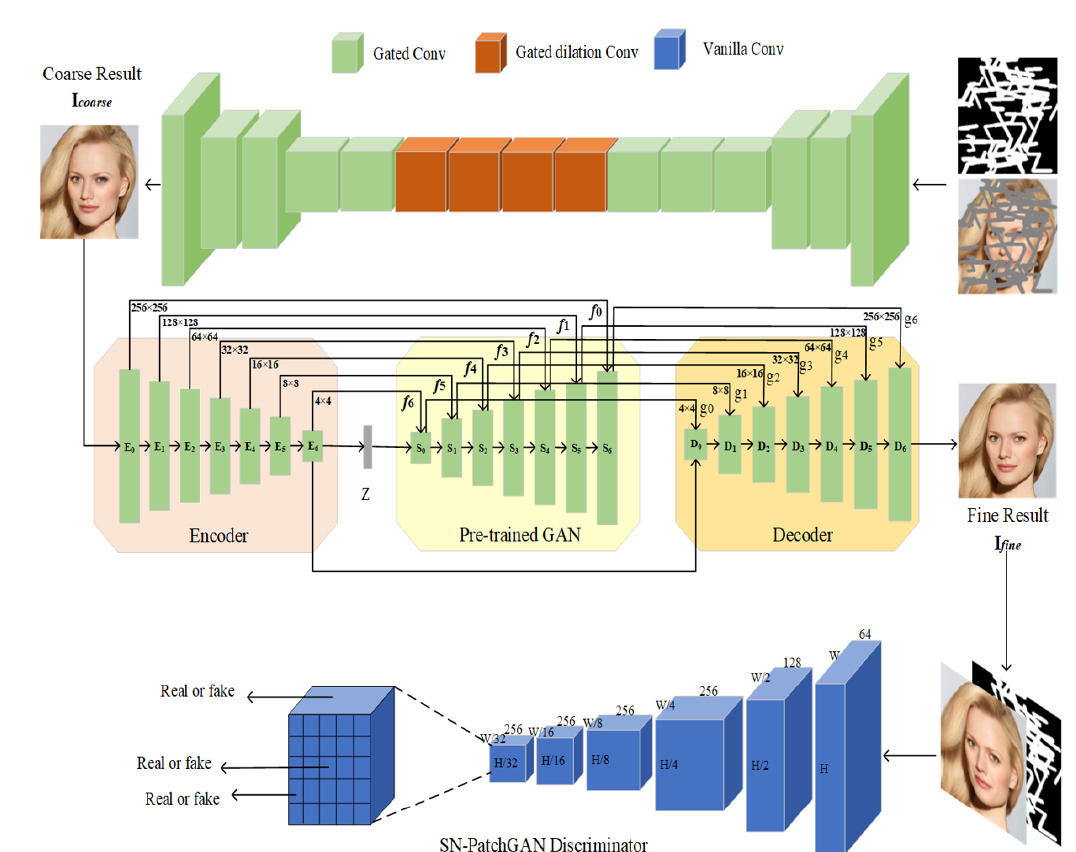
Figure 2. Face image completion model based on GAN